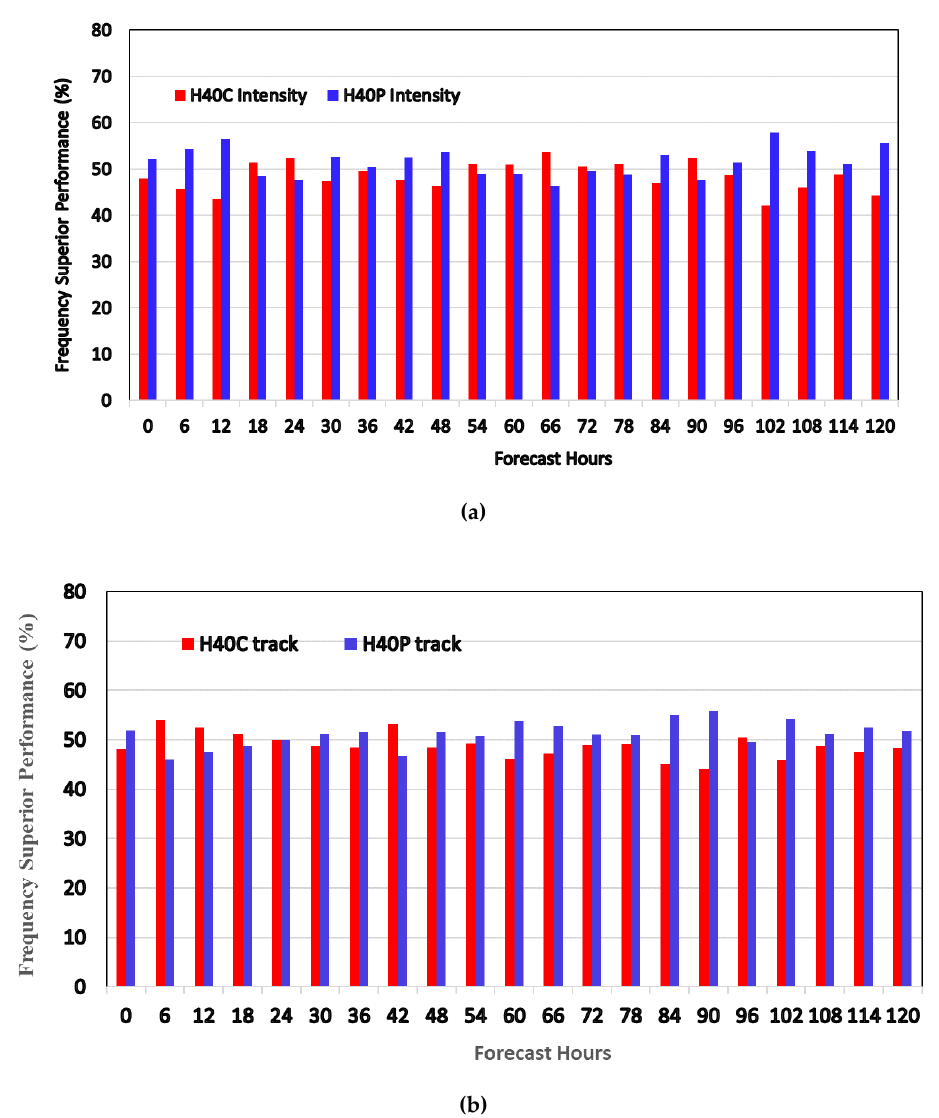
Figure 9. Comparison of the track ( a ) and the intensity ( b ) frequency of the superior performance between the H40C (red) and the H40P (blue).